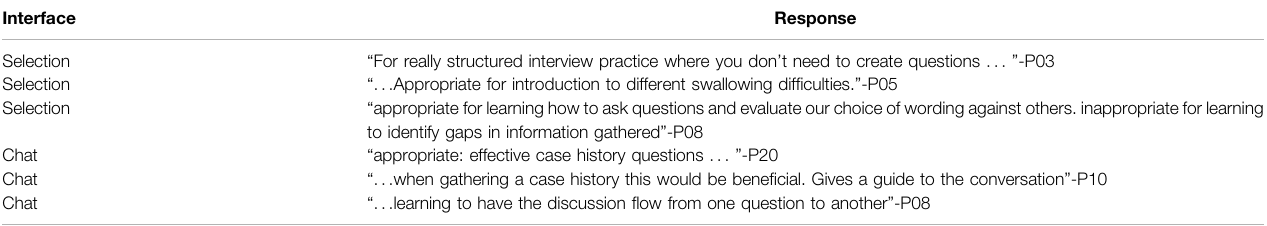
TABLE 3 | Sample student responses to “ For what types of learning tasks do you think the [interface] is appropriate? ” Interface